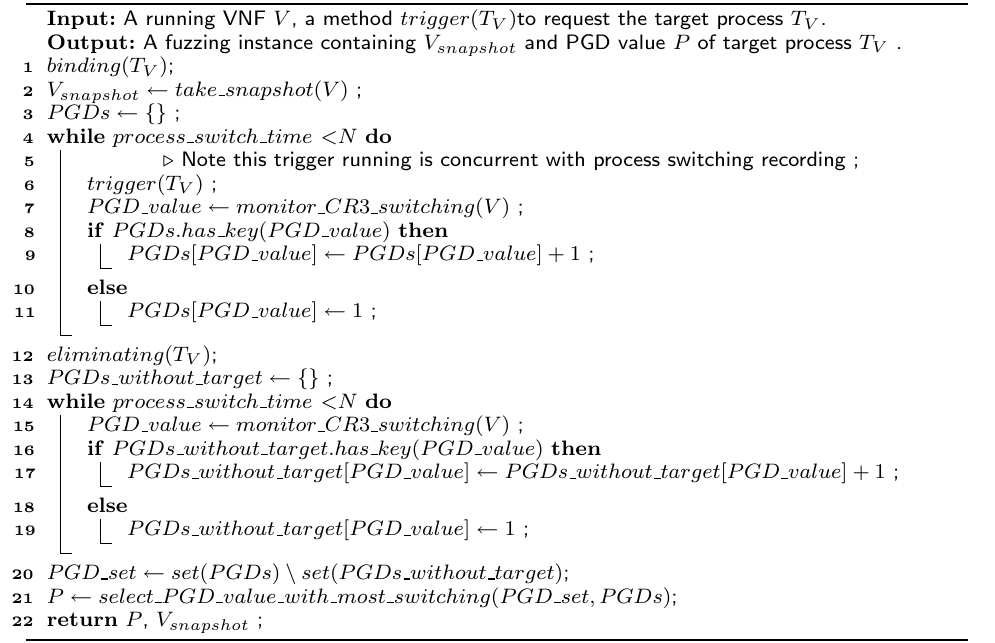
Algorithm 1: Process Locating by Differential